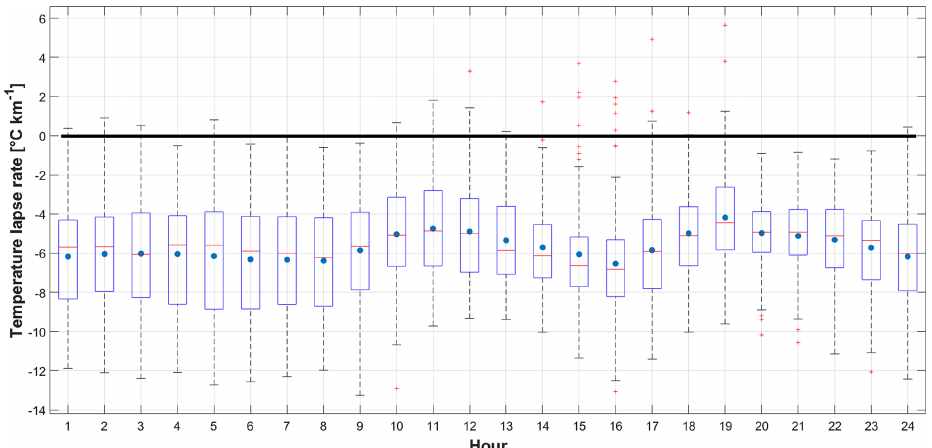
Figure 3. Boxplot showing the statistical distribution of hourly lapse rates calculated between AWS1 and AWS2 in the common period. Upper and lower box limits are the 75 and 25% quartiles, the red horizontal line is the median, the filled circle is the mean, and crosses are outlying